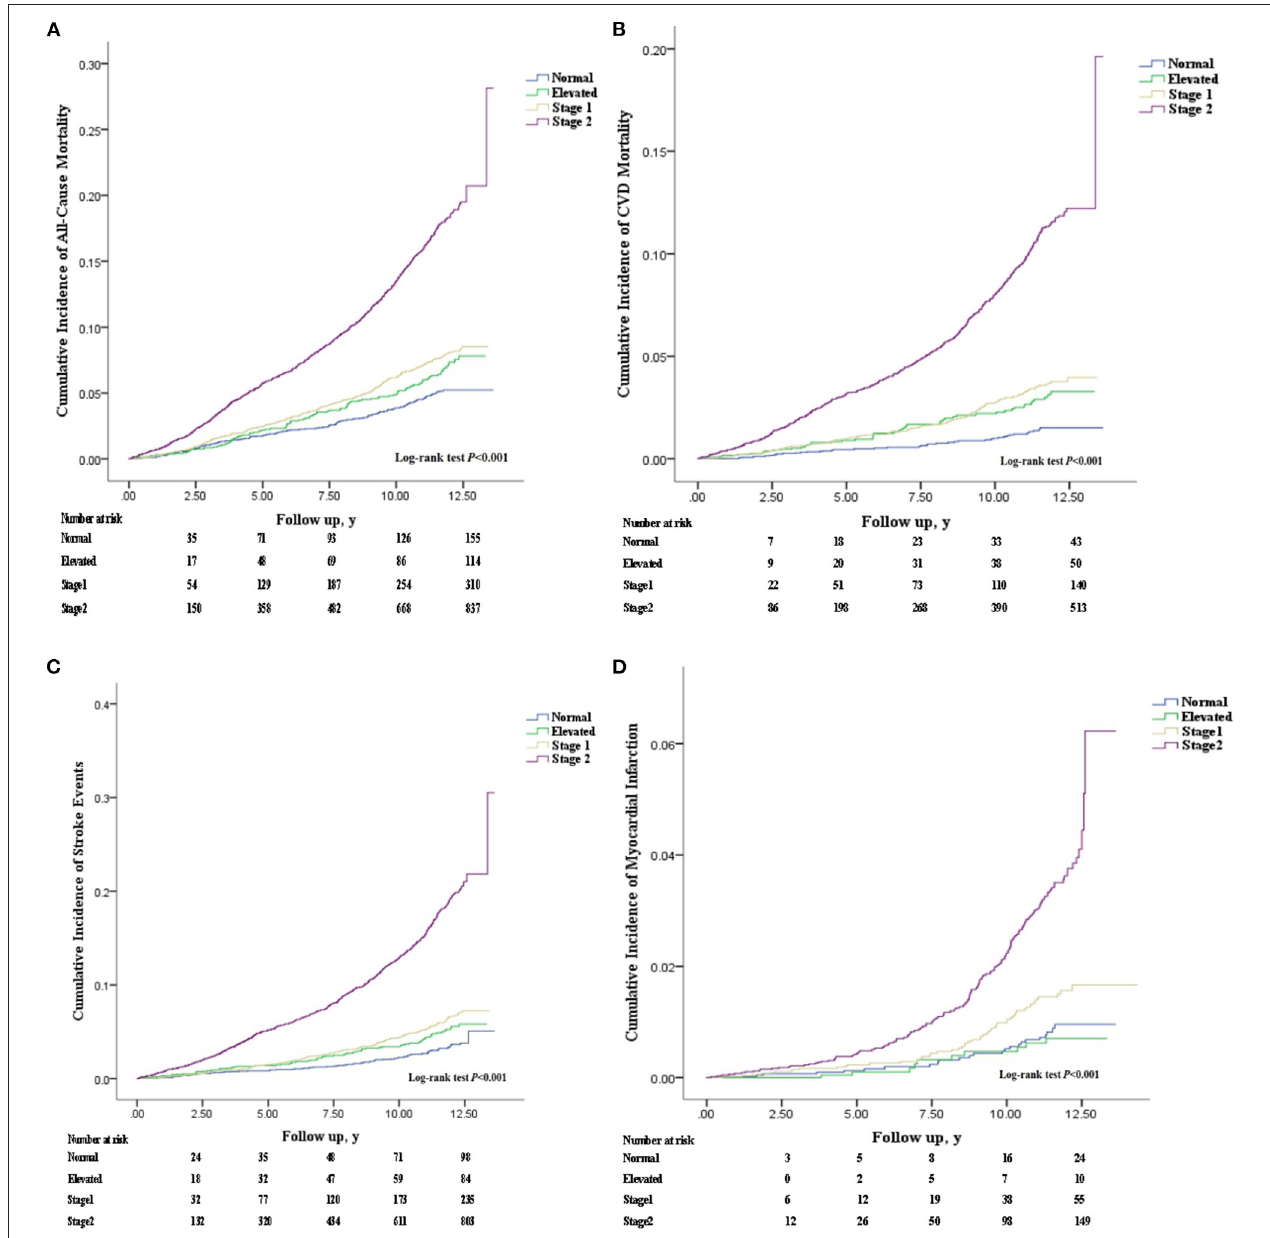
FIGURE 2 | The cumulative incidence of adverse events by the different BP groups. Incident (A) All-Cause Mortality, (B) Cardiovascular Disease Mortality, (C) Stroke Incidence, and (D) Myocardial Infarction. Error bars represent 95% CI. Normal: SBP < 120mm Hg and DBP < 80mm Hg; Elevated: SBP of 120–129mm Hg and DBP of < 80 mmHg; Stage 1: SBP of 130–139 mmHg or DBP 80–89 mmHg; Stage 2: SBP/DBP ≥ 140/90mm Hg, or taking antihypertensive medications. SBP, systolic blood pressure; DBP, diastolic blood pressure. CI, confidence interval. y, year; Stage 1, Stage 1 hypertension; Stage 2, Stage 2